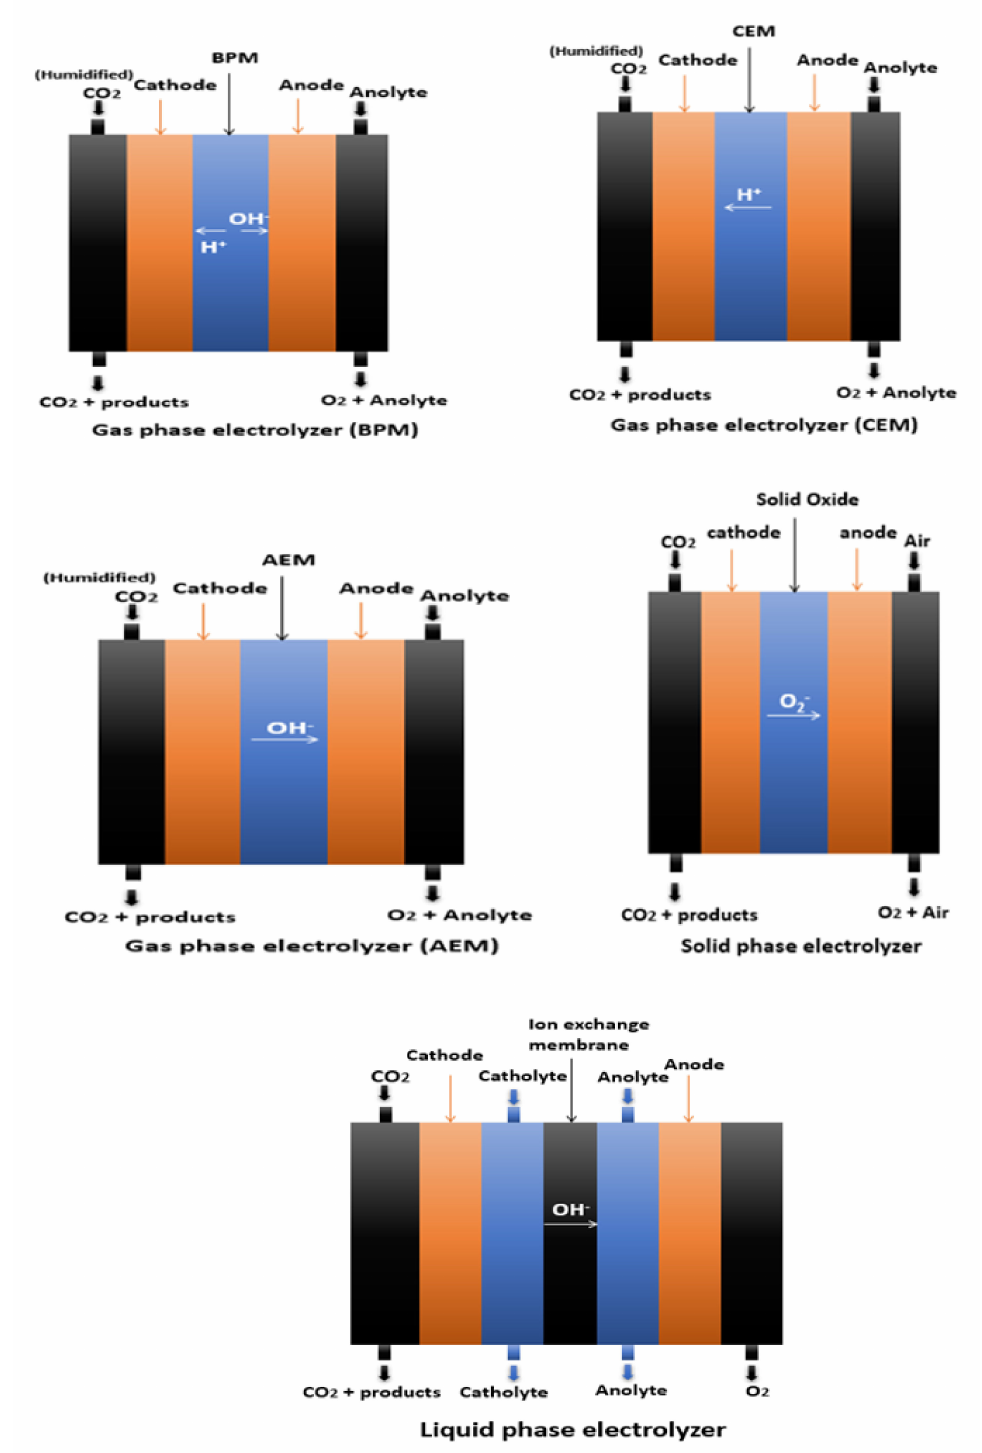
Figure 4. Different electrolyzer configurations for CO 2 ERR